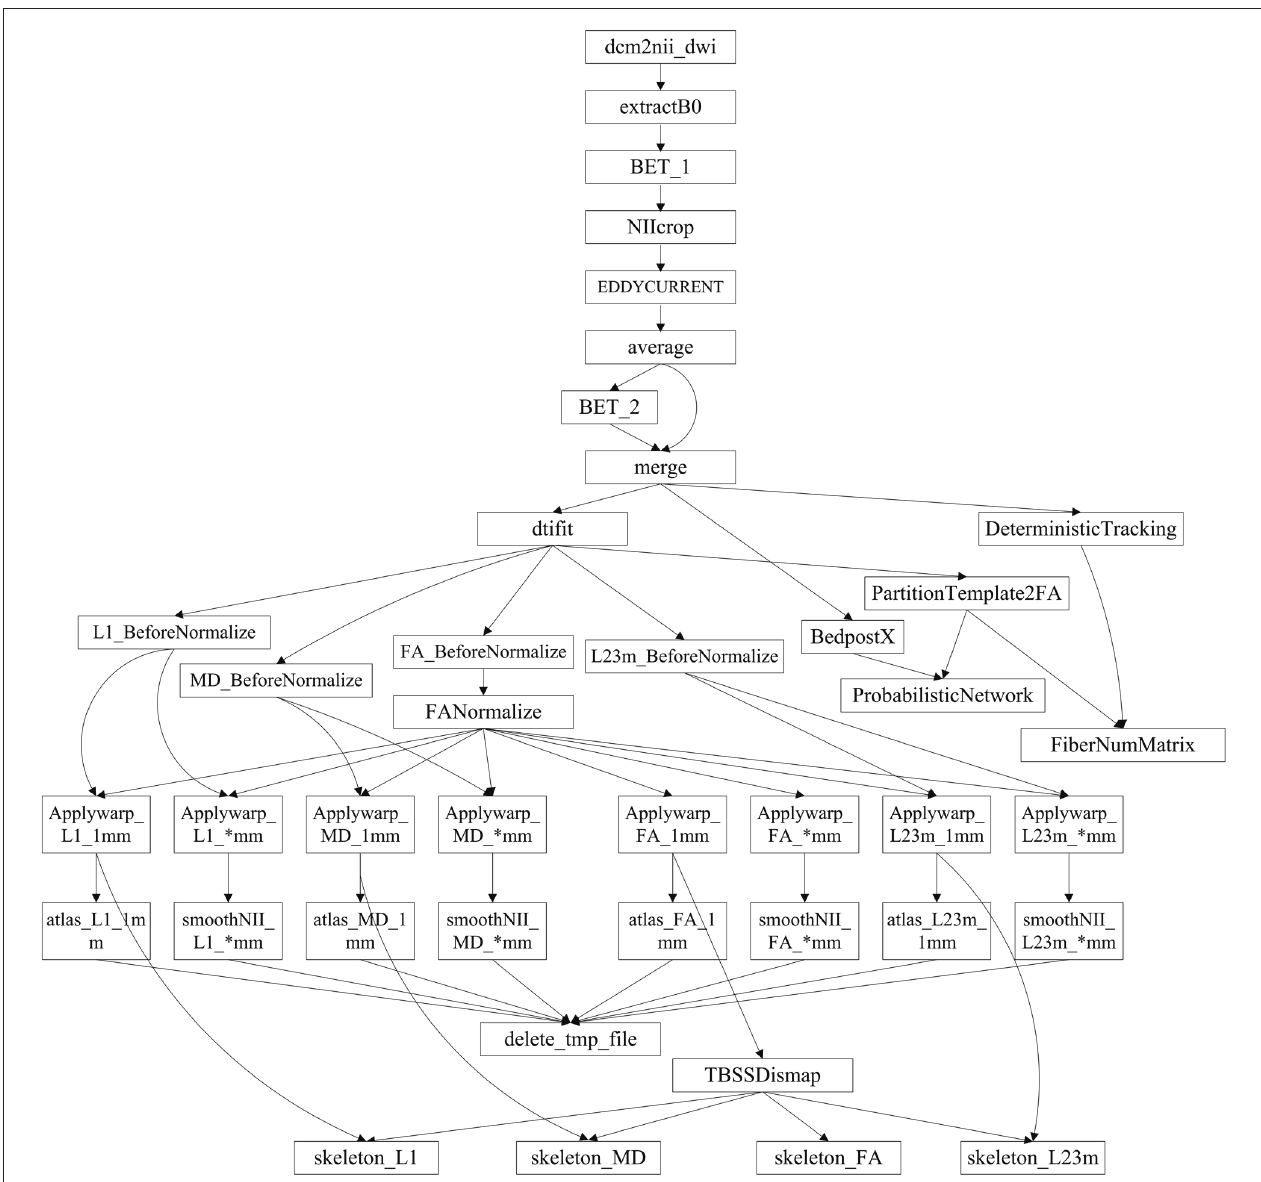
FIGURE A1 | Implementation of the PANDA pipeline. The entire process of the PANDA pipeline was divided into 41 steps. Arrows indicate dependencies: A → B means that B cannot start until A is